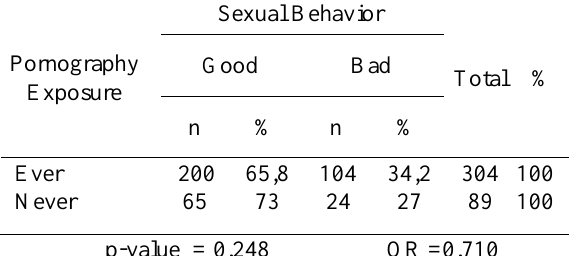
Table 2. Distribution of Correlation Between Exposure of Pornographic Media with Sexual